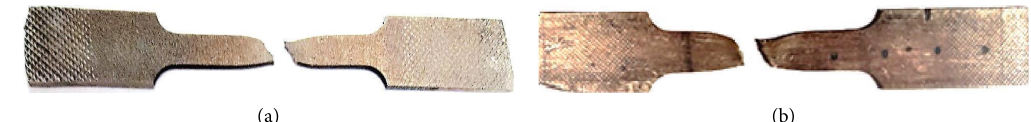
Figure 15: Te shape of the samples and the destruction nature: (a) after the frst stage of processing ( h � 1.6mm); (b) after the second stage of processing ( h � 2.5mm).